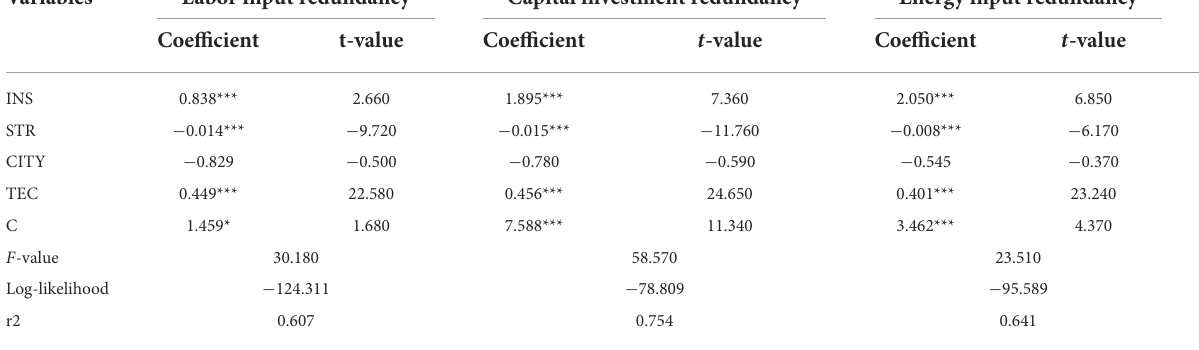
TABLE 4 Tobit regression